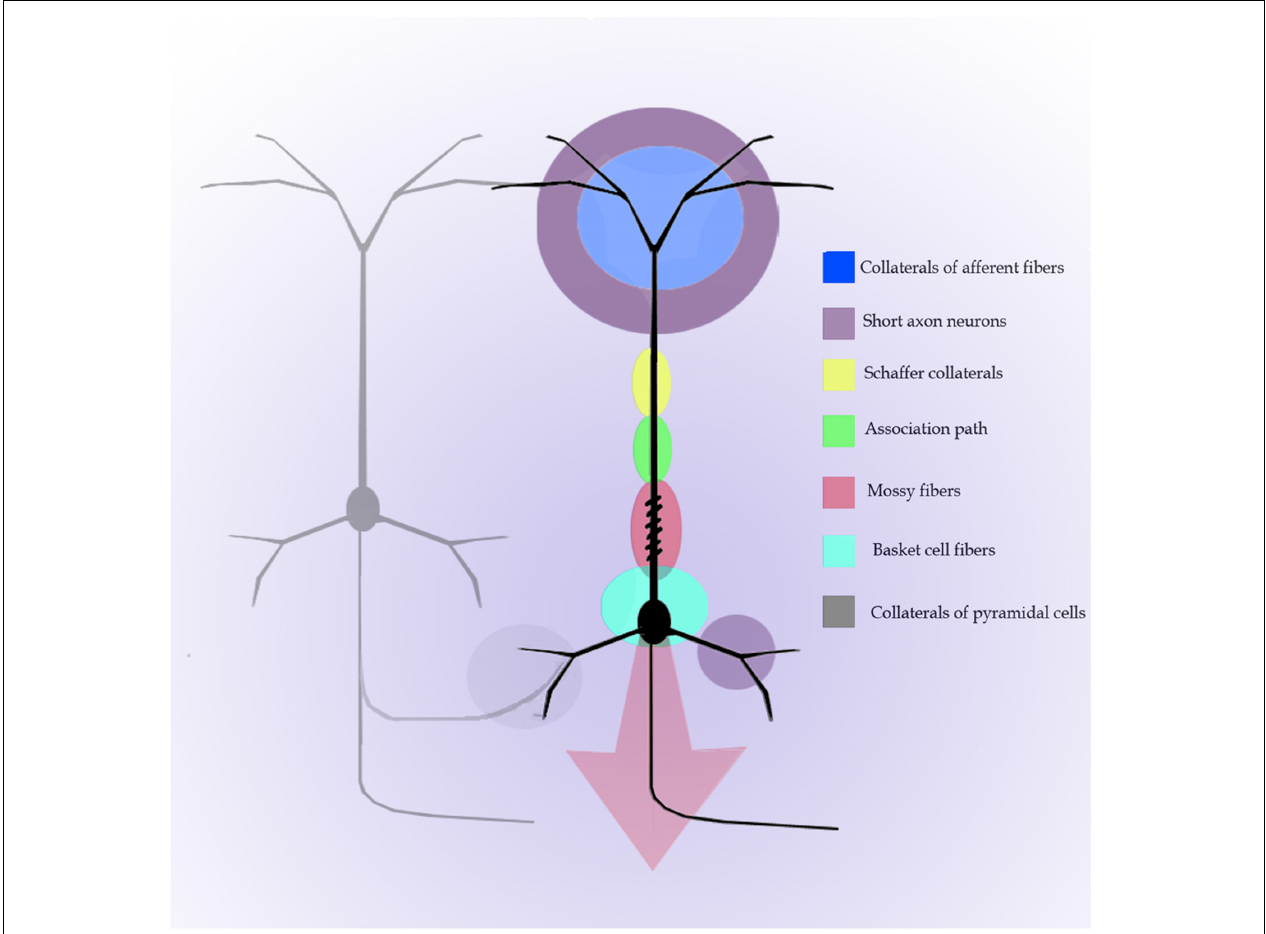
FIGURE 6 | Diagram of the distribution of afferences into distinct parts of the pyramidal cell of the Ammon’s horn. Modified and colored from Figure 34 in Lorente de Nó (1934).